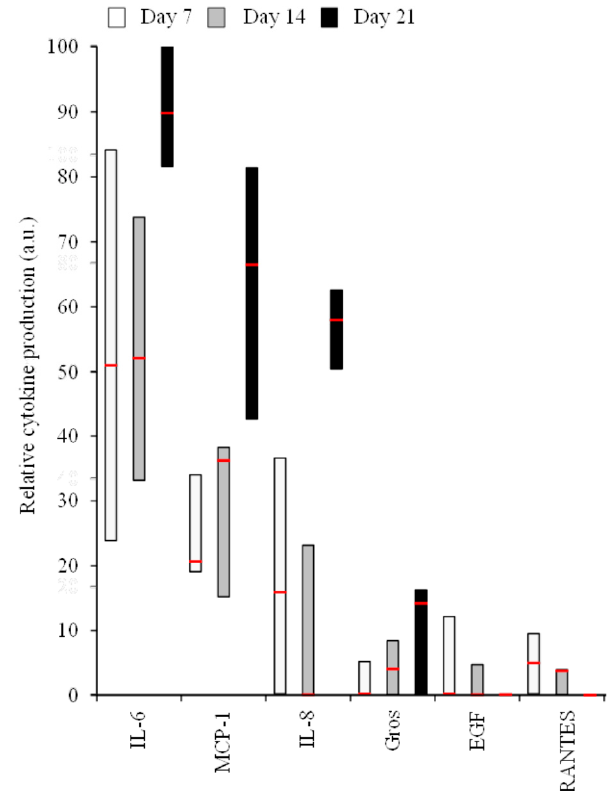
Figure 4. Relative cytokine production in human primary bone cell supernatants in basal culture conditions, measured by antibody arrays. The minimal (bottom box), median (inside box line), and maximal (top box) production are shown from 3 independent donors.